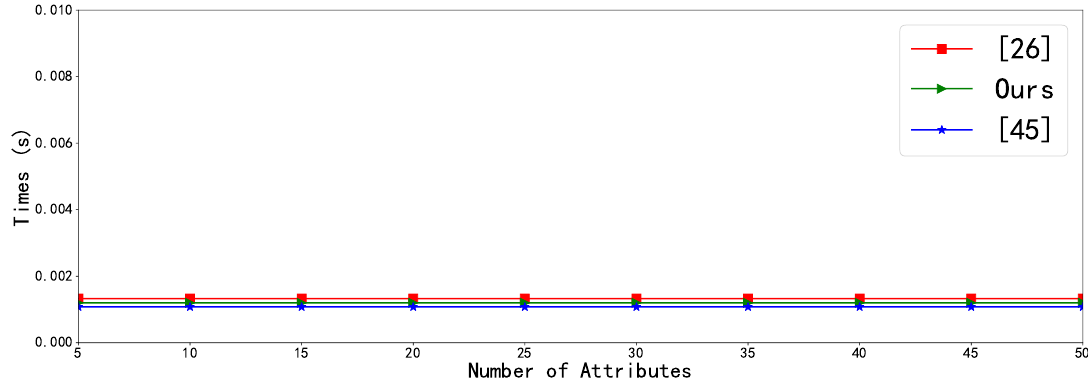
Figure 3. Comparison of outsourced decryption